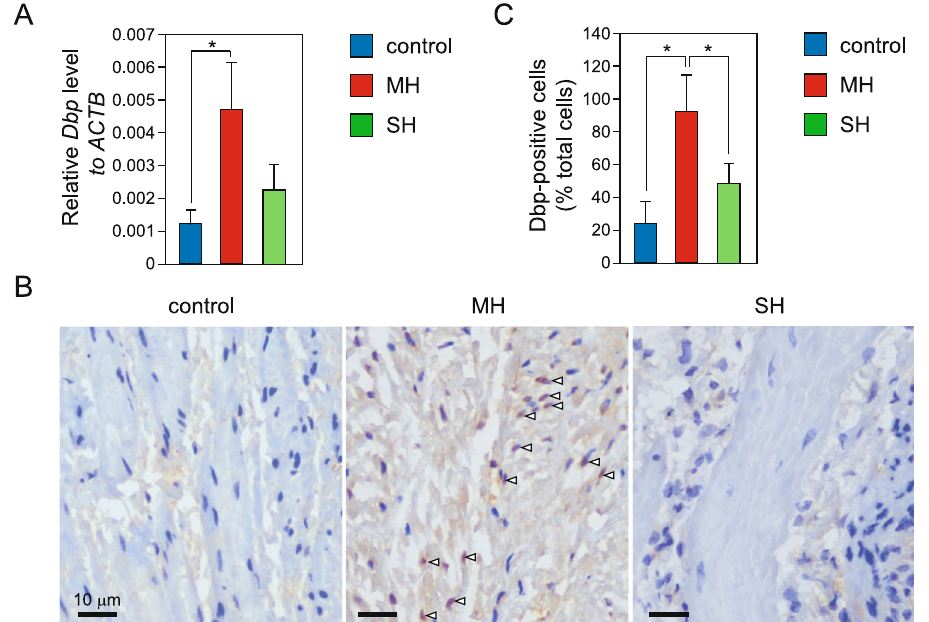
Figure 3. Expression levels of Dbp in the three experimental groups. ( A ) Relative Dbp mRNA levels in the rat urinary bladder in the control, MH, and SH groups. mRNA levels were quantified by RT-pPCR. Measurements were normalized to Actb mRNA levels. Data are means ± SEM. * P < 0.05. ( B ) Immunohistochemistry using anti- DBP antibodies. DBP was stained brown via DAB immunolabeling (white arrowheads). Nuclei were stained blue by hematoxylin stain. All images are obtained using AdvanView 3.7 imaging software (http:// advan- vision. com). Scale bars: 10 mm. ( C ) The number of DBP-positive cells in immunostaining images was quantified using ImageJ. Data are means ± SEM (n = 4). * P <